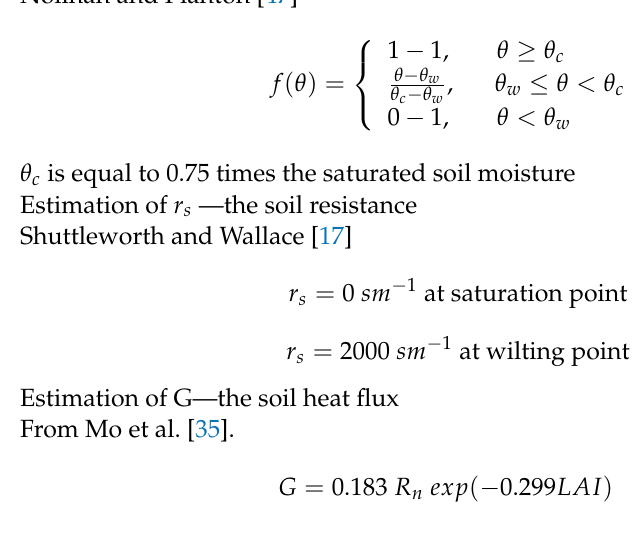
Table A1. Landuse and vegetation parameters for S–W